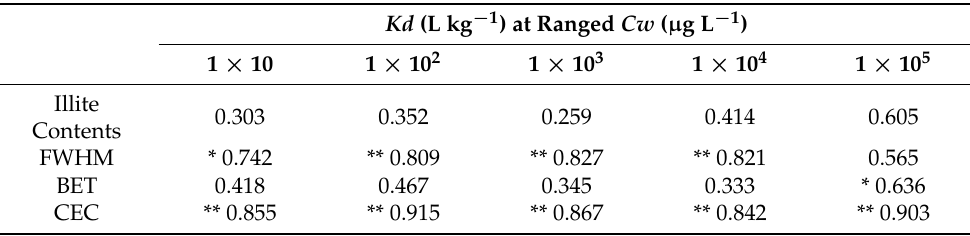
Table 3. Spearman’s correlation coefficients between illite properties and K d of samples at various C w , respectively.